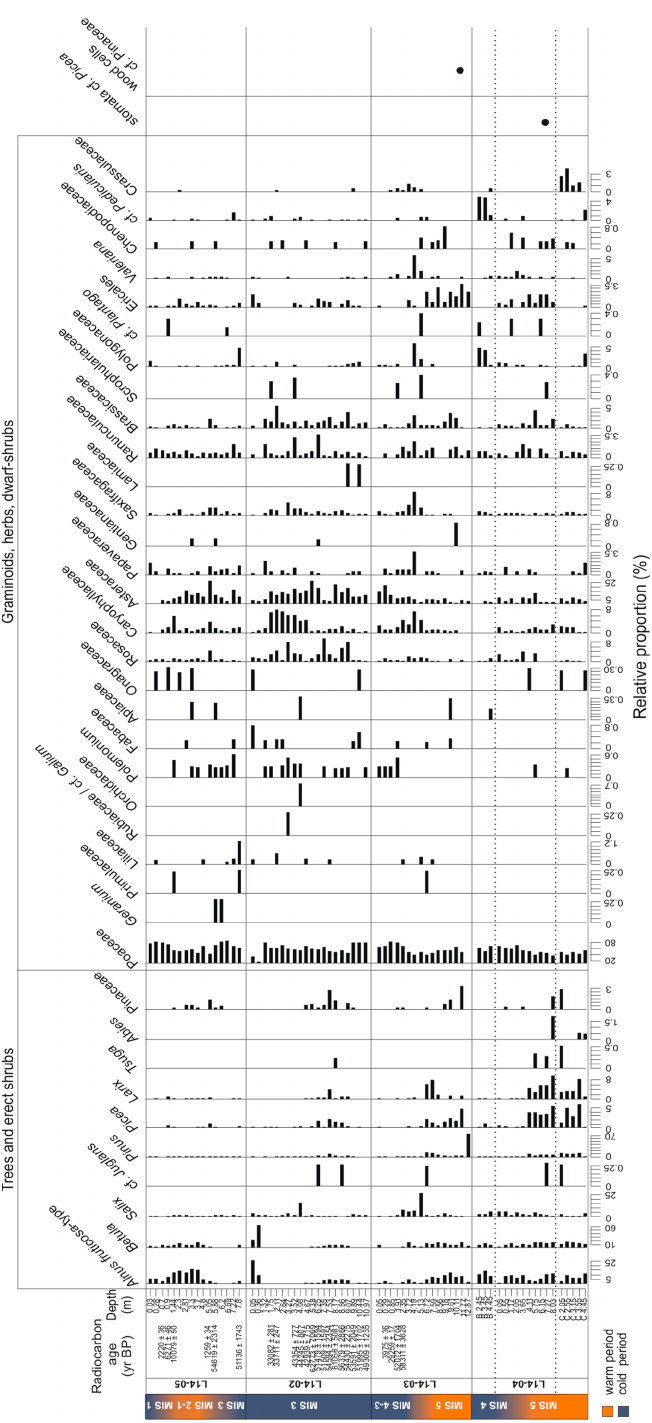
Figure 6. Stratigraphic diagram of relative proportions of terrestrial pollen in each sample of the four permafrost cores (L14-05, L14-02, L14-03, L14-04) and the hand-pieces (collected soil nuggets from outcrops: L14-04B, L14-04C). The presence of coniferous stomata and wood cells is marked by a black dot. The radiocarbon ages (yr BP) and the corresponding MIS are displayed on the left side, with warmer periods in orange and colder periods in blue. The scales of the relative proportions are adjusted for each